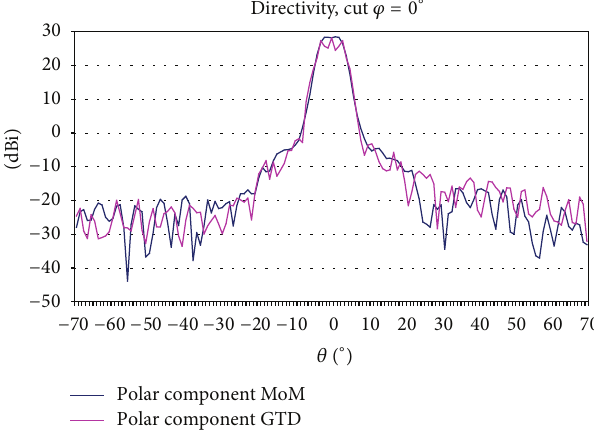
Figure 26: Polar component obtained with MoM and GTD, cut in phi = 0.